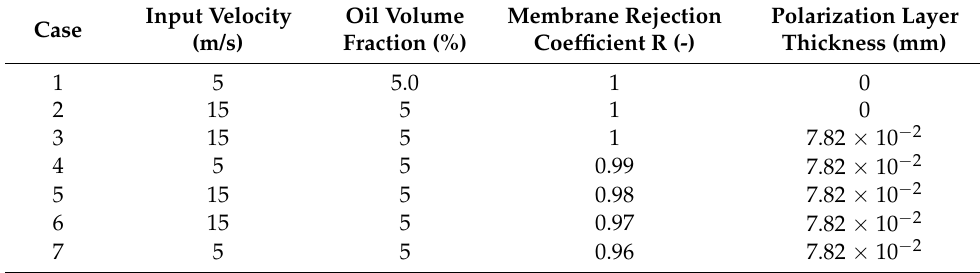
Table 3. Operational parameters used in the